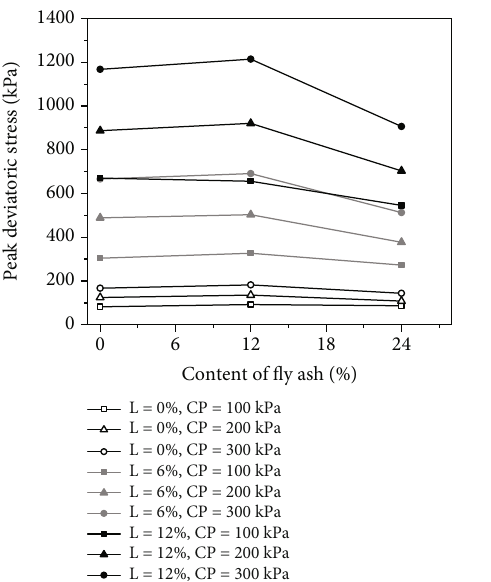
Figure 22: Internal friction angle due to di ff erent fl y ash contents.